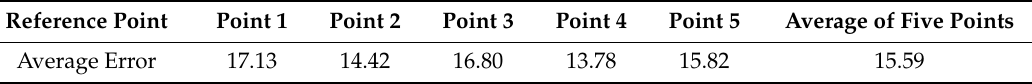
Table 7. Average RMS errors of five reference points after coarse-Alignment for original data